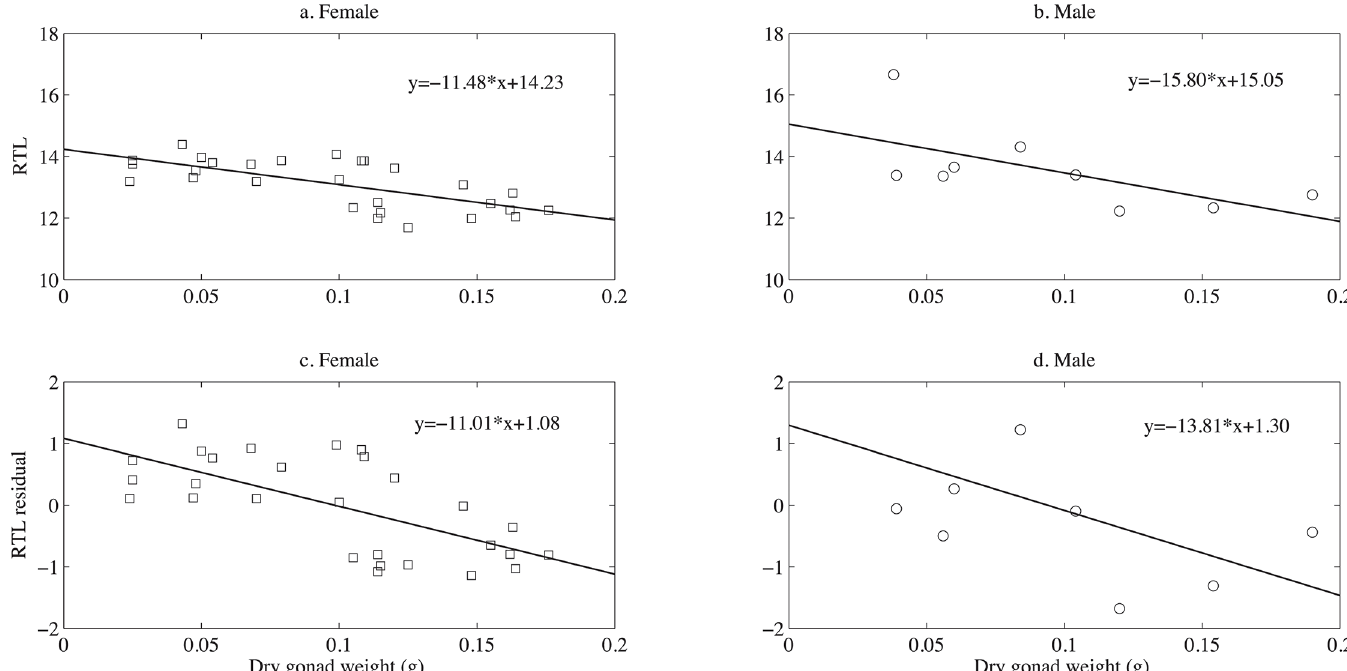
Fig 5. The relationship between RTL and dry gonad weight in muscle samples. Females are shown in a and c and males are shown in b and d. The RTL vs. dry gonad weight is shown in a and b and the RTL residuals from length effect vs. dry gonad weight are shown in c and d. The lines are fitted linear regressions.